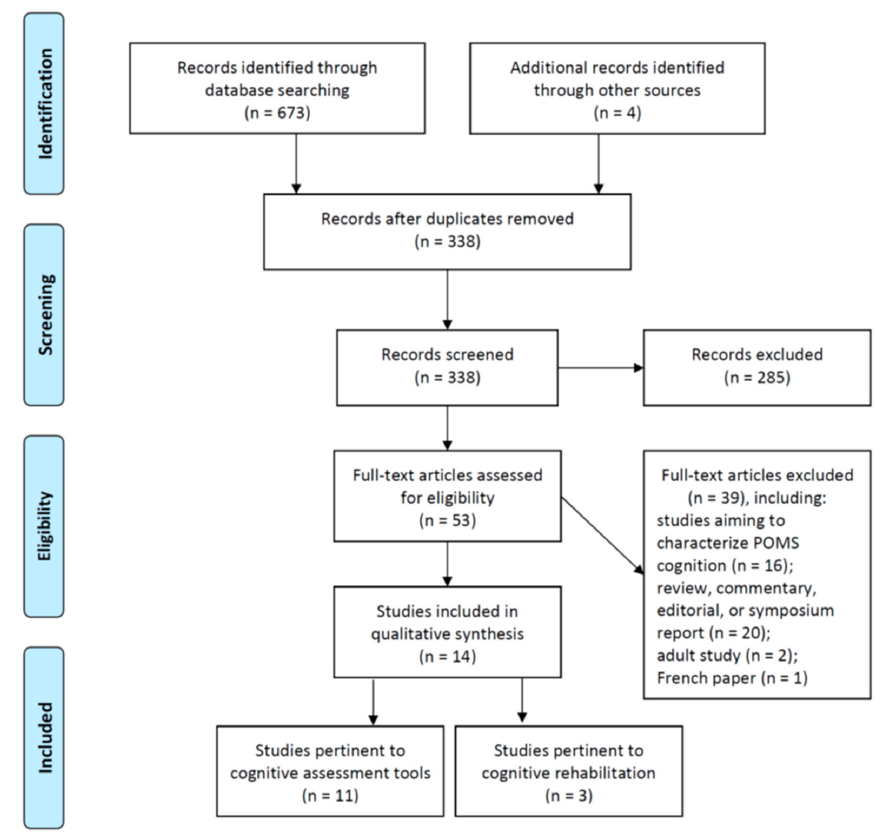
Figure 1. Diagram showing the workflow of literature search and selection process.